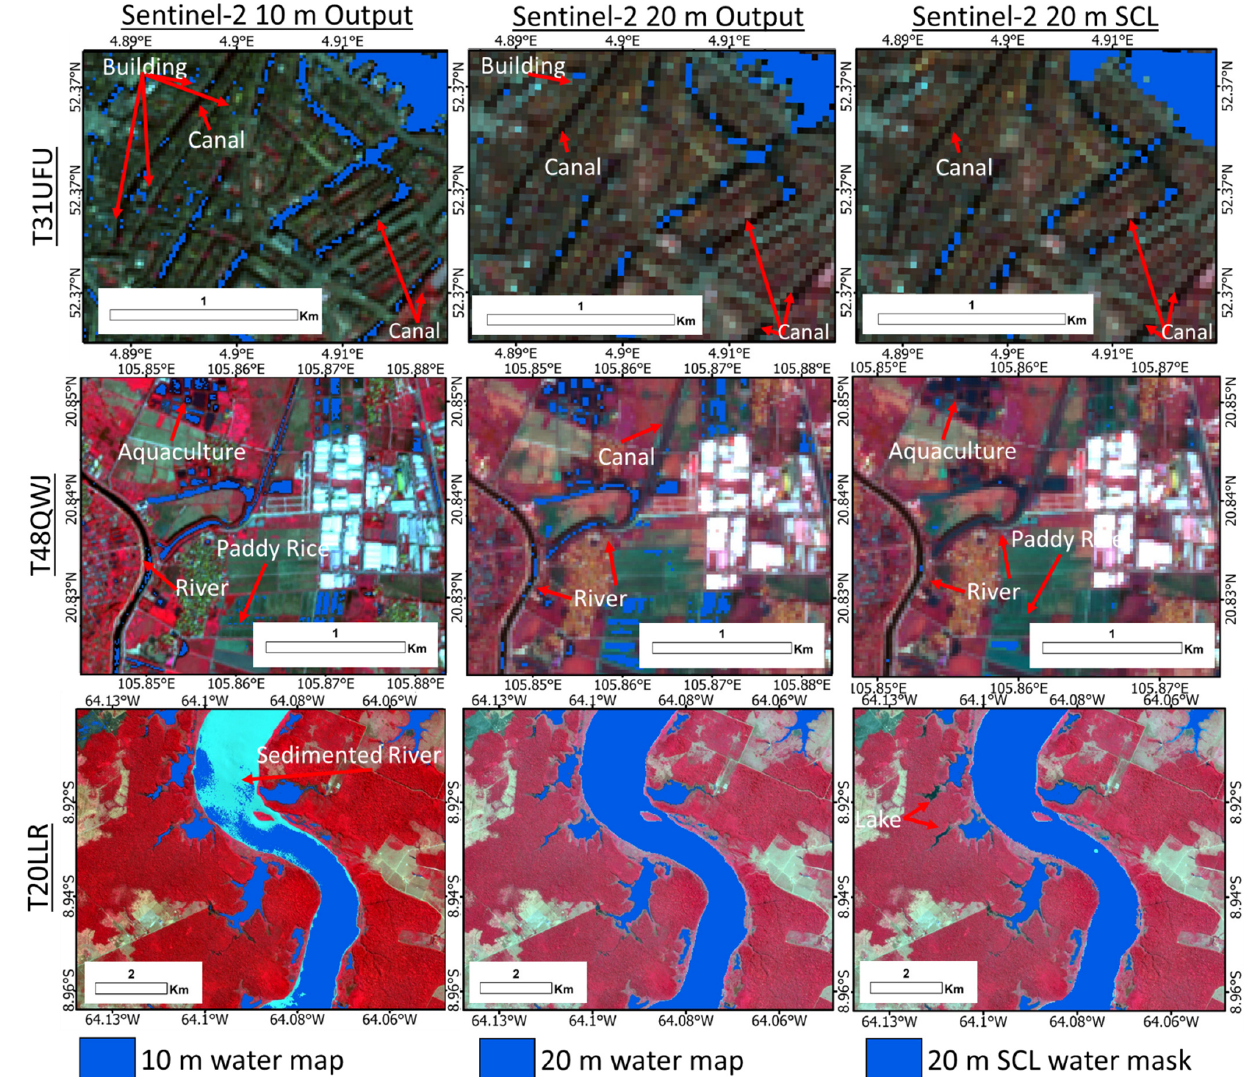
Figure 7. Example map errors in Amsterdam, Hanoi, and Madeira River. In Amsterdam, the 20 m product has fewer building commission errors, but has more omission errors of canals and small waterways. The 10 m layer captures more of the canals, but still has some omission errors. It also has more commission errors of buildings and shadows. The canal designated on both maps was difficult to capture as it was partially obstructed by tree cover.